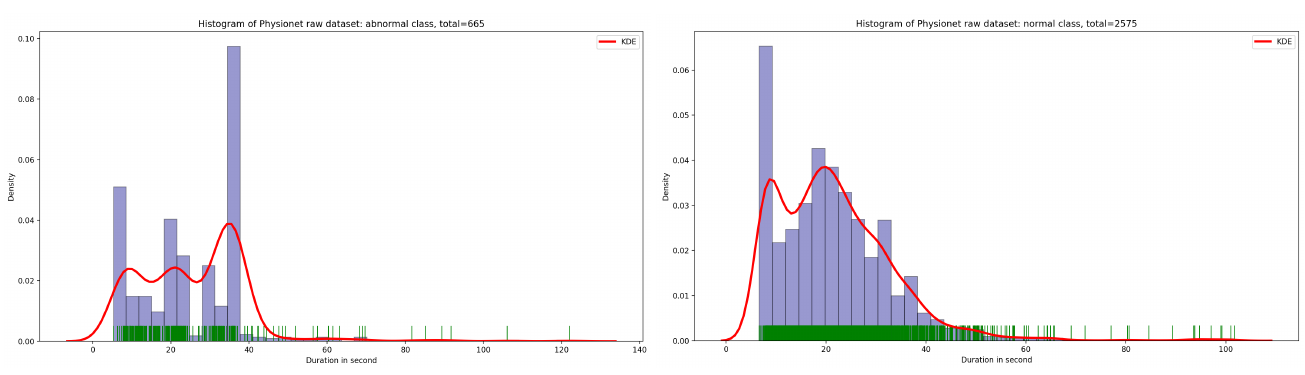
Figure 2. An overview of the kernel density estimation function using Gaussian kernel for normal and abnormal classes.